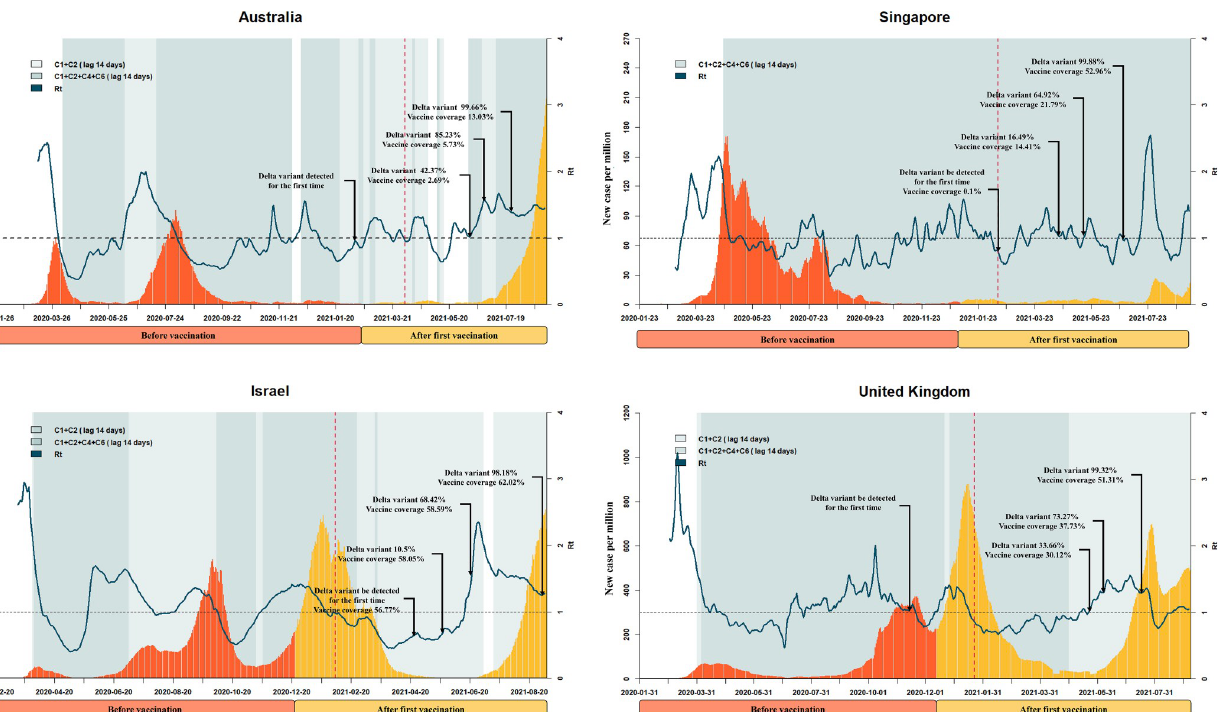
PLOS NeglectedTropical Diseases | https://doi.org/10.1371/journal.pntd.0010101 January 13,